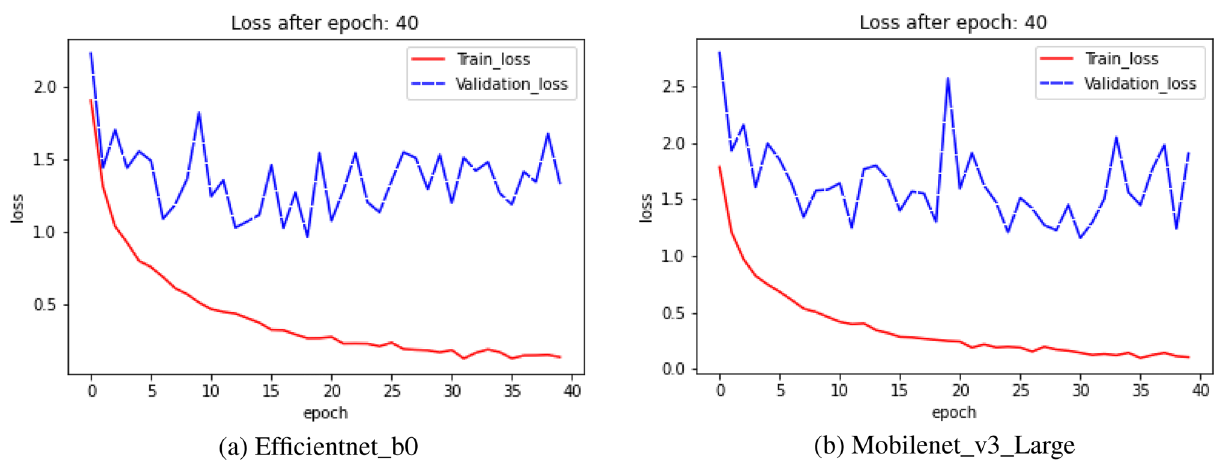
Figure 13. Graph showing the Loss plot generated by ( a ) Efficientnet_b0 and ( b ) Mobilenet_v3_Large transfer learning models on KU-HAR dataset.